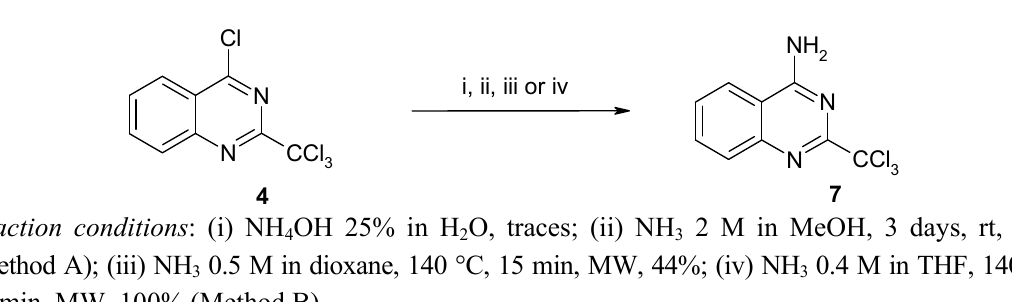
Scheme 3. Synthesis of 4-amino-2-trichloromethylquinazoline ( 7